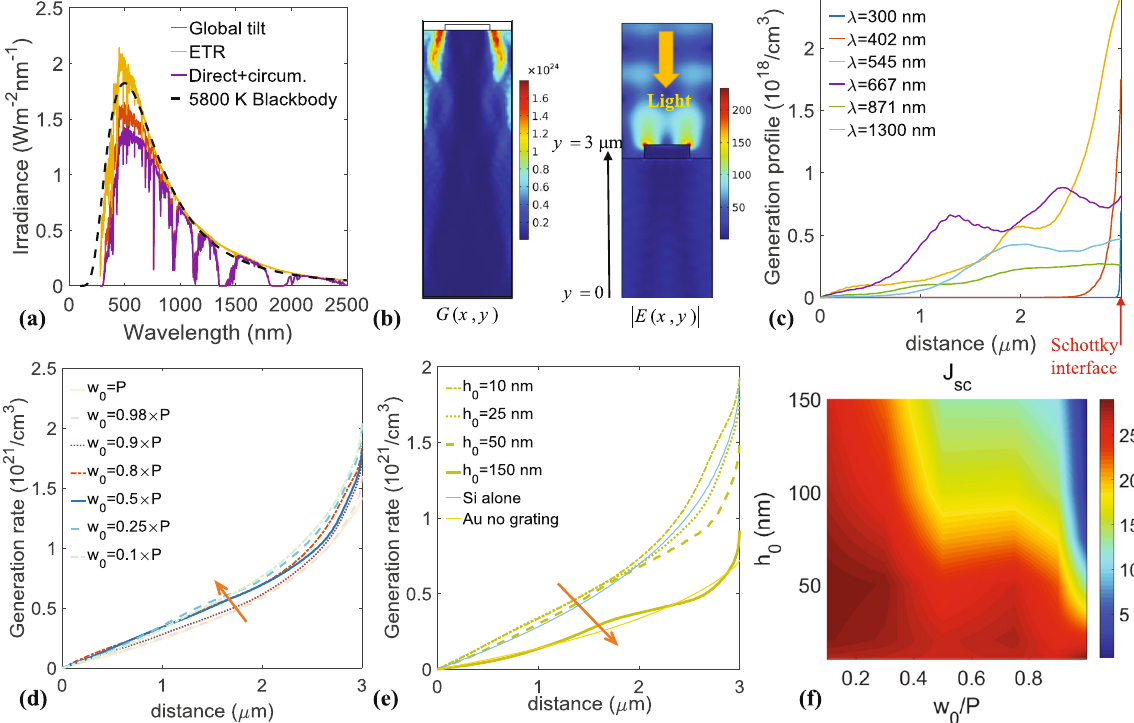
Figure 3. ( a ) Light spectrum generated from the sun, compared to the radiation from a blackbody at 5800 K. ( b ) (left) generation profile inside the silicon layer and (right) electric field profile. ( c ) Spectral generation G x y ( , 0, ) 0 λ = for different wavelengths. ( d , e ) represent the light integrated generation rate ( G ) versus the depth into silicon for various periods and heights of the gold grating, respectively. ( f ) Contour plot of the short- circuit density current ( J ) versus geometry of the grating, i.e. w and h sc 0 0